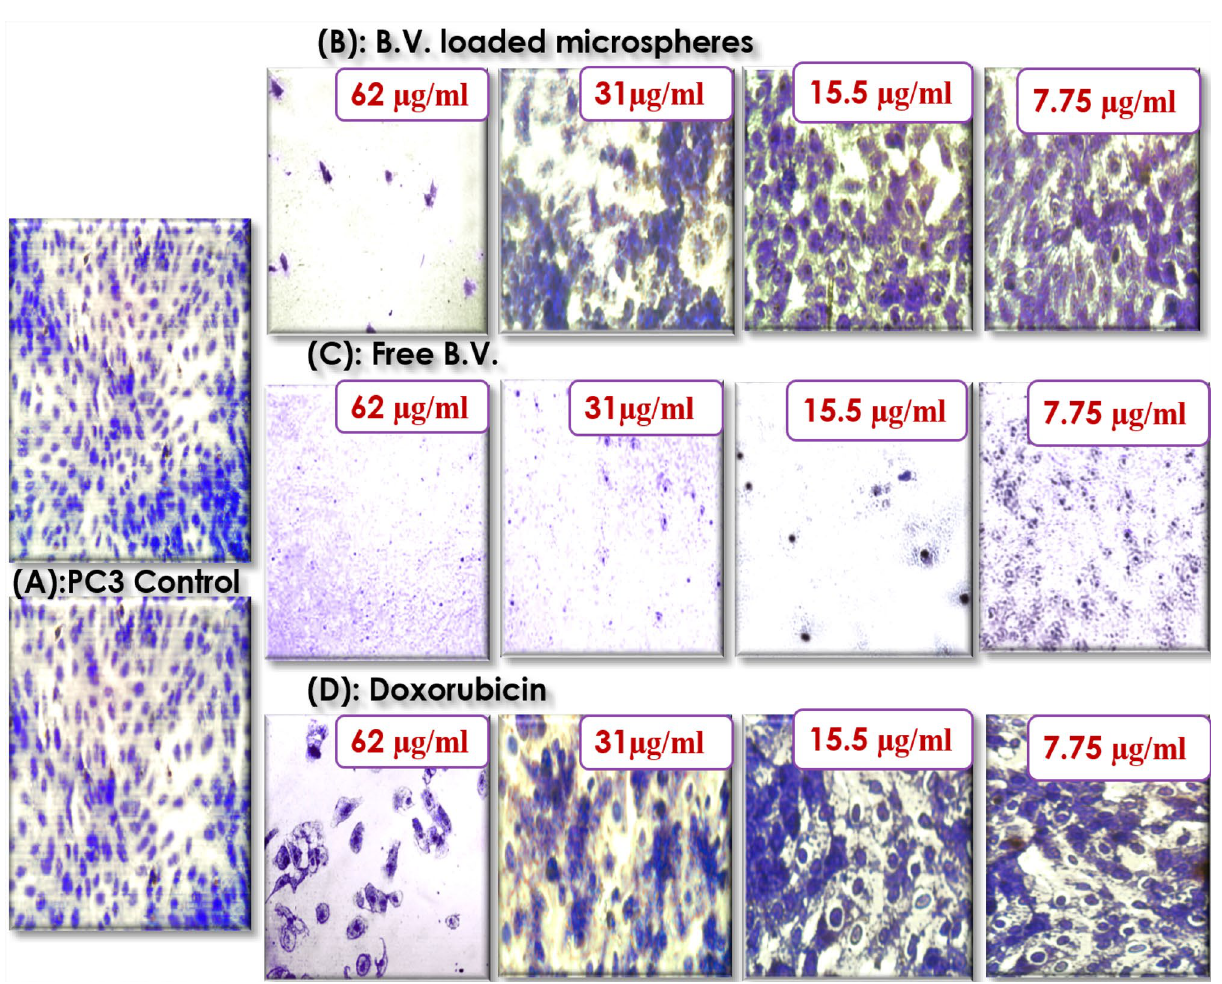
Figure 3. Microscopic images of PC3 cells with crystal violet staining before ( A ) PC3 control and after treatment with different concentrations of ( B ) B.V. loaded cross-linked chitosan coated microspheres ( C ) Free B.V. ( D )